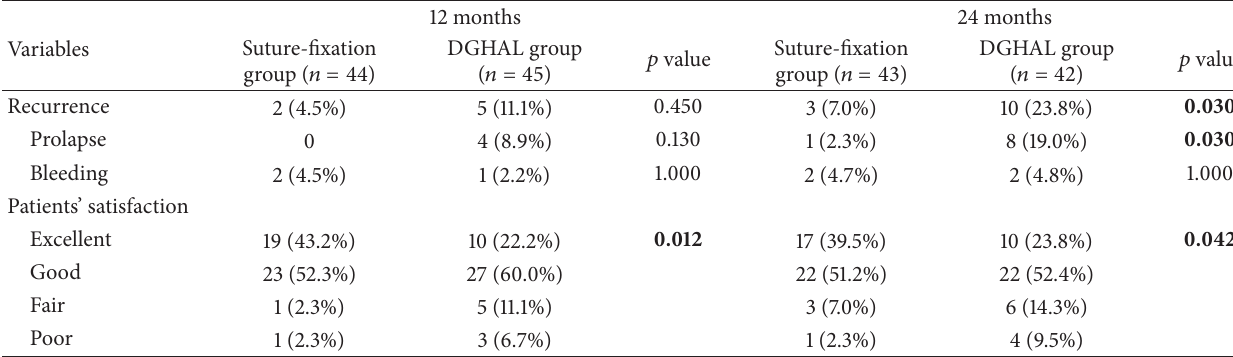
Table 4: Long-term recurrence and patients’